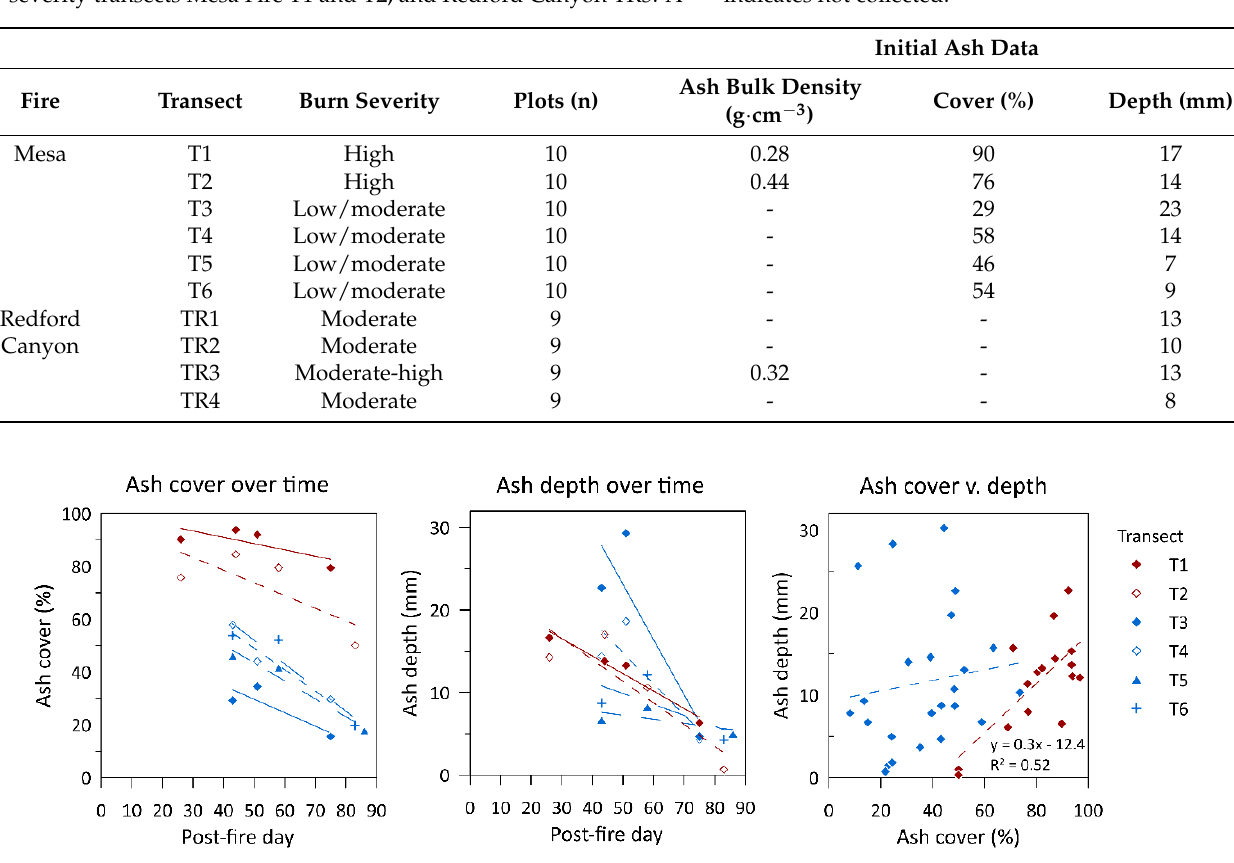
Table 3. Mean transect characteristics measured at the initial visit. Ash bulk density was calculated in the lab from high-burn severity transects Mesa Fire T1 and T2, and Redford Canyon TR3. A “-“ indicates not collected.